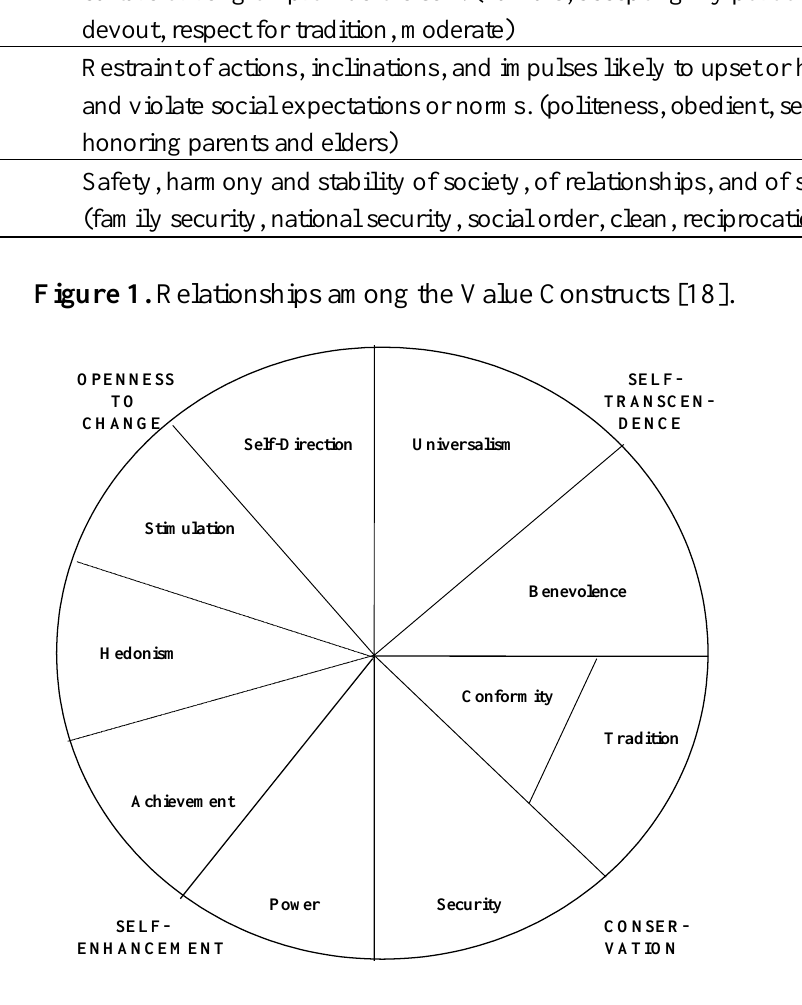
Figure 2. Task with Challenging